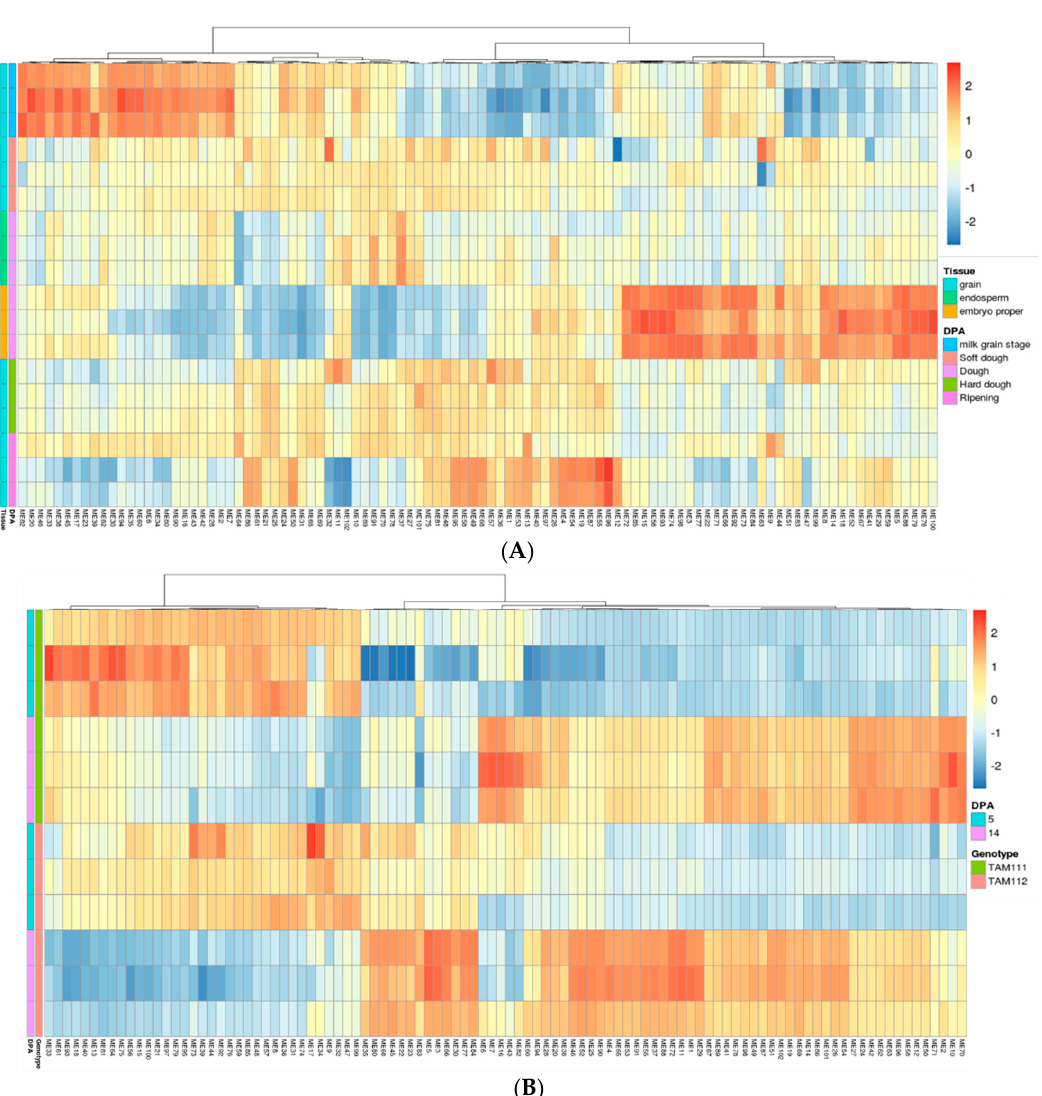
Figure 4. Gene modules constructed from WGCNA using publicly available grain RNAseq data. ( A ): Expression pattern of eigengenes representing each module. Modules are clustered by tissue type and developmental stages (colored rectangles on the left). ( B ): Expression pattern of module genes in TAM111 and TAM112. Modules are clustered by genotype and DPA, indicated by colored rectangles on the left. Hierarchical clustering has been performed to identify modules with similar expression